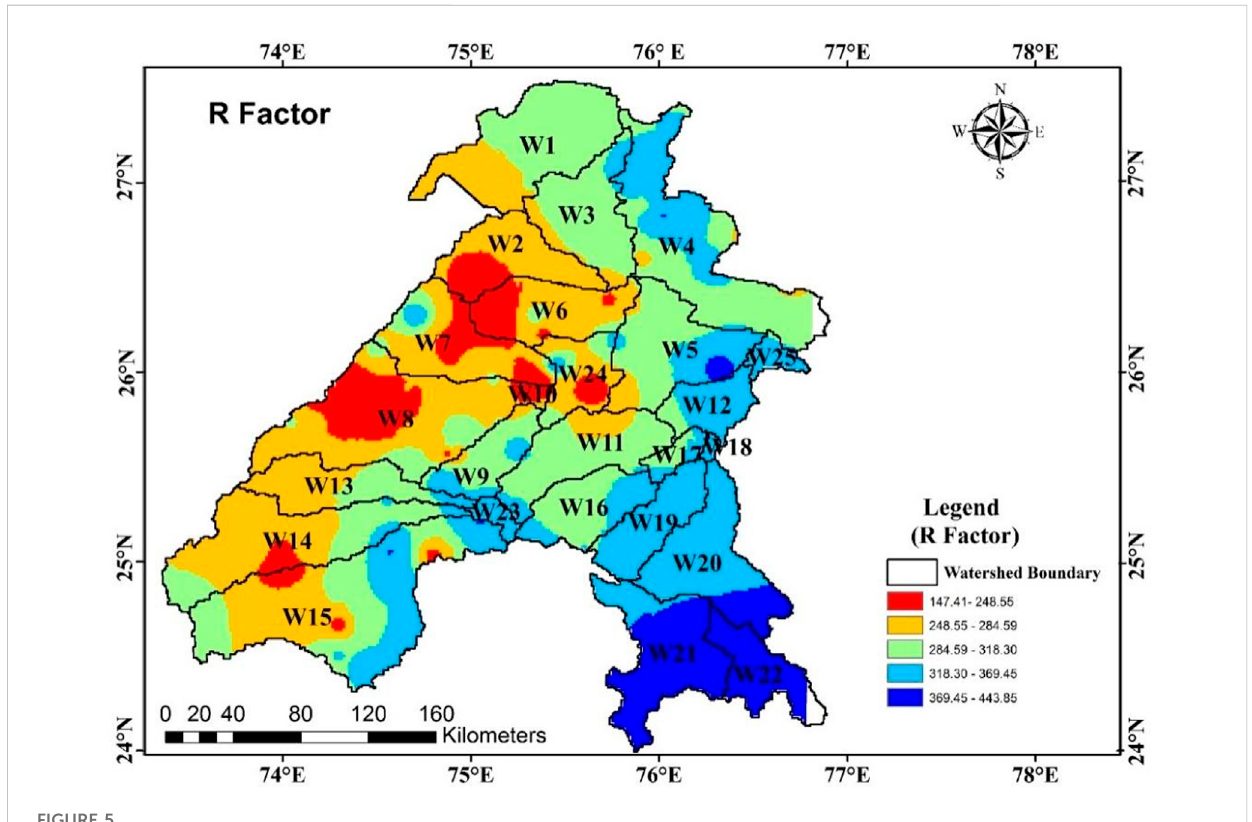
R factor map of the study